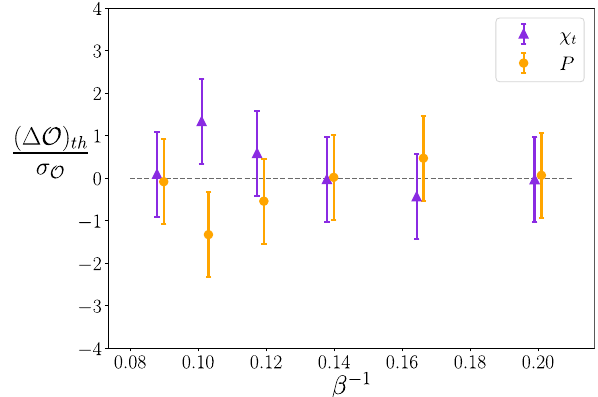
Fig. 17 Results for the plaquette and the topological susceptibility in the master-field simulations of the pure gauge theory. We plot the dif- ference with respect to the theoretical value ((cid:12) O ) th = O − O th , nor- malized by the error, as a function of β − 1